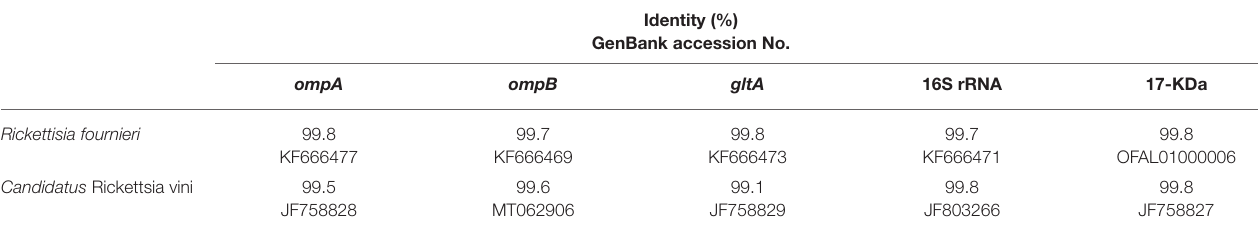
TABLE 4 | Identities between fragment genes of Rickettsia sp. EEZA-CRETAV detected in the present study and published sequences from Rickettsia fournieri and Candidatus Rickettsia vini.